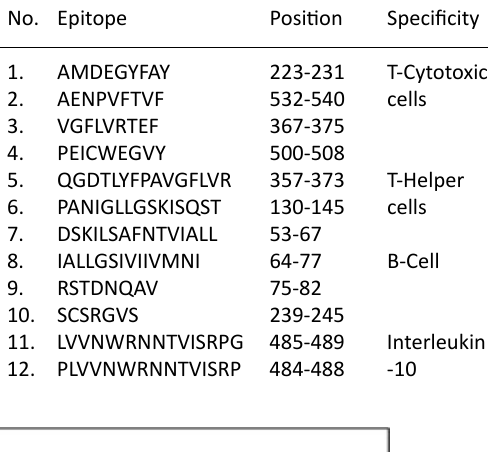
Table 4. Constituents of Multi-epitope